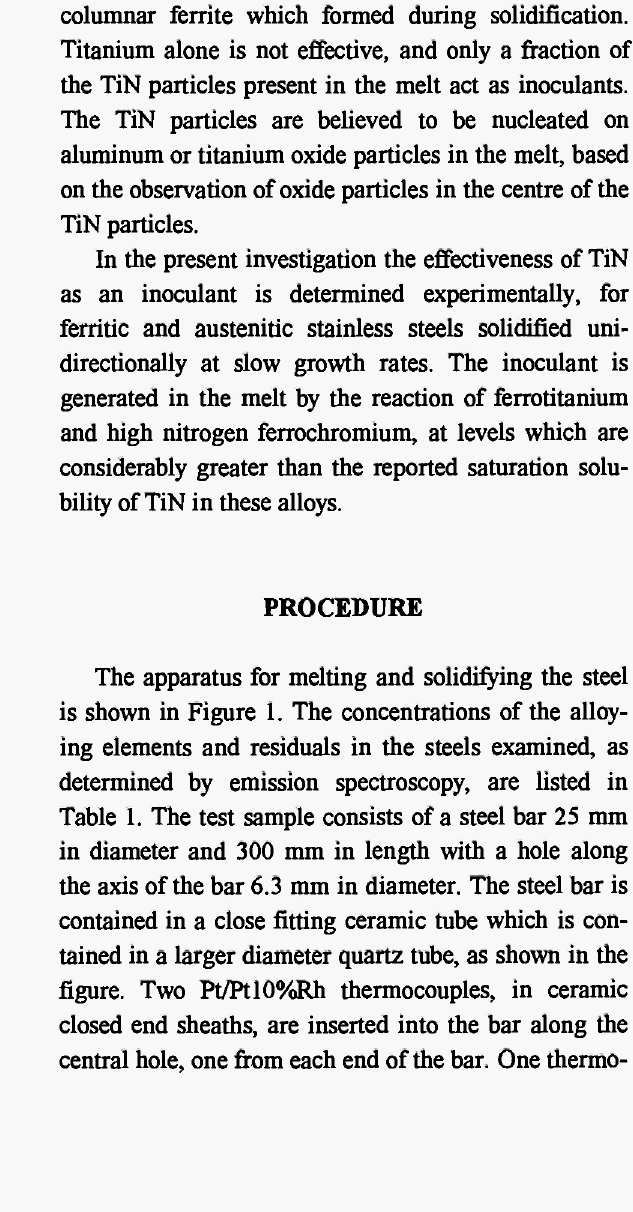
closed end sheaths, are inserted into the bar along the central hole, one from each end of the bar. One